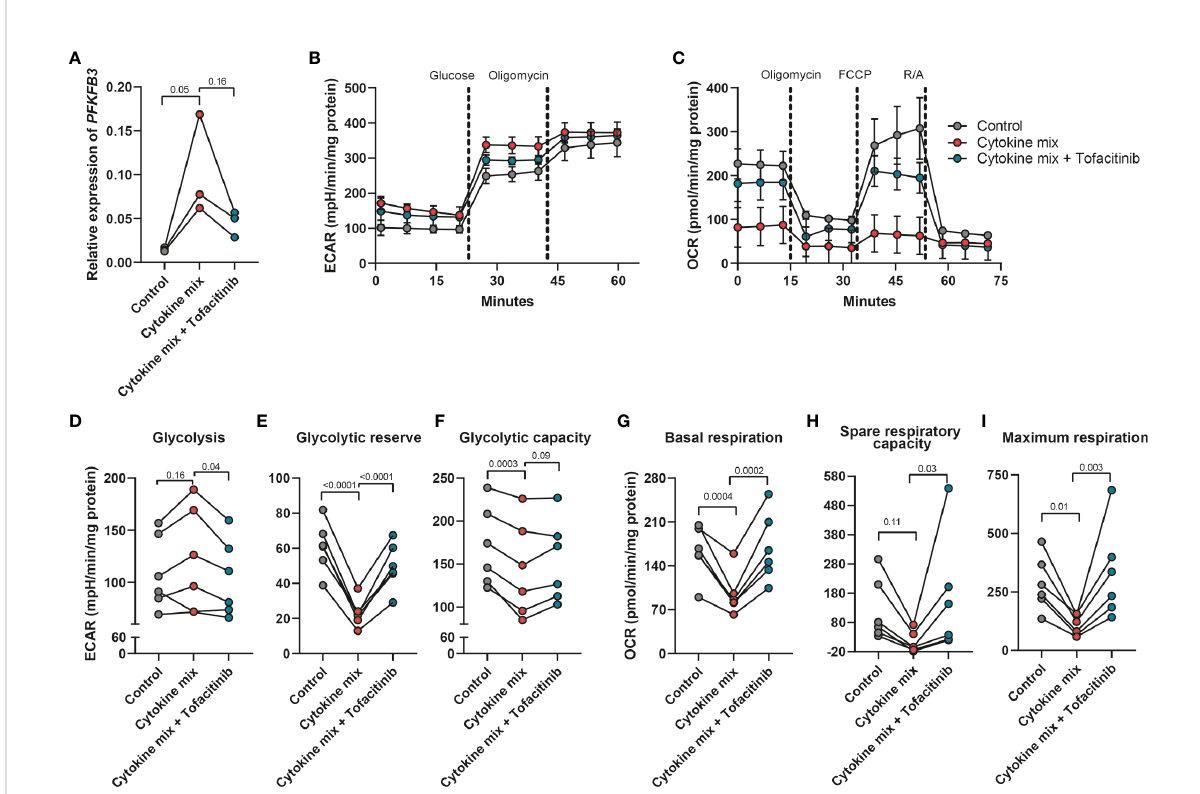
FIGURE 3 Increased glycolytic level in fi broblasts after the stimulation with in fl ammatory cytokines. Primary fi broblasts (n=6 independent fi broblasts) were stimulated with cytokine mix (IL17-A: 50ng/ml; OSM: 20ng/ml; IL-1 b : 1ng/ml) with/without tofacitinib (5 m M) for 48 hours and collected to perform the seahorse XFe96 experiment. The remaining cells were used for qPCR analysis. (A) qPCR analysis of the expression of PFKFB3 after the stimulation with cytokine mix with/without tofacitinib for 48 hours. (B, C) Representative seahorse curves for ECAR and OCR of primary fi broblasts. ECAR values were analyzed in response to the injection of glucose (10mM) and oligomycin (1 m M) whereas OCR values were analyzed in response to the injection of oligomycin (1 m M), FCCP (3 m M), and rotenone and antimycin A (R/A; 1 m M). Data were normalized to the total protein level (DC protein assay) and are presented with mean ± SD from a representative experiment. (D – I) Glycolysis (D) , glycolytic reserve (E) , glycolytic capacity (F) , baseline mitochondrial respiration (G) , spare respiratory capacity (H) , and maximum respiration (I) were calculated and presented, n=6 fi broblasts. One-way ANOVA comparisons test was